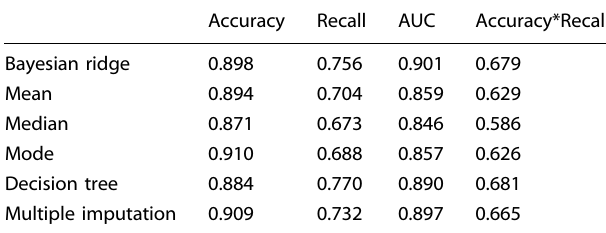
Table 1. Validation result of different imputation